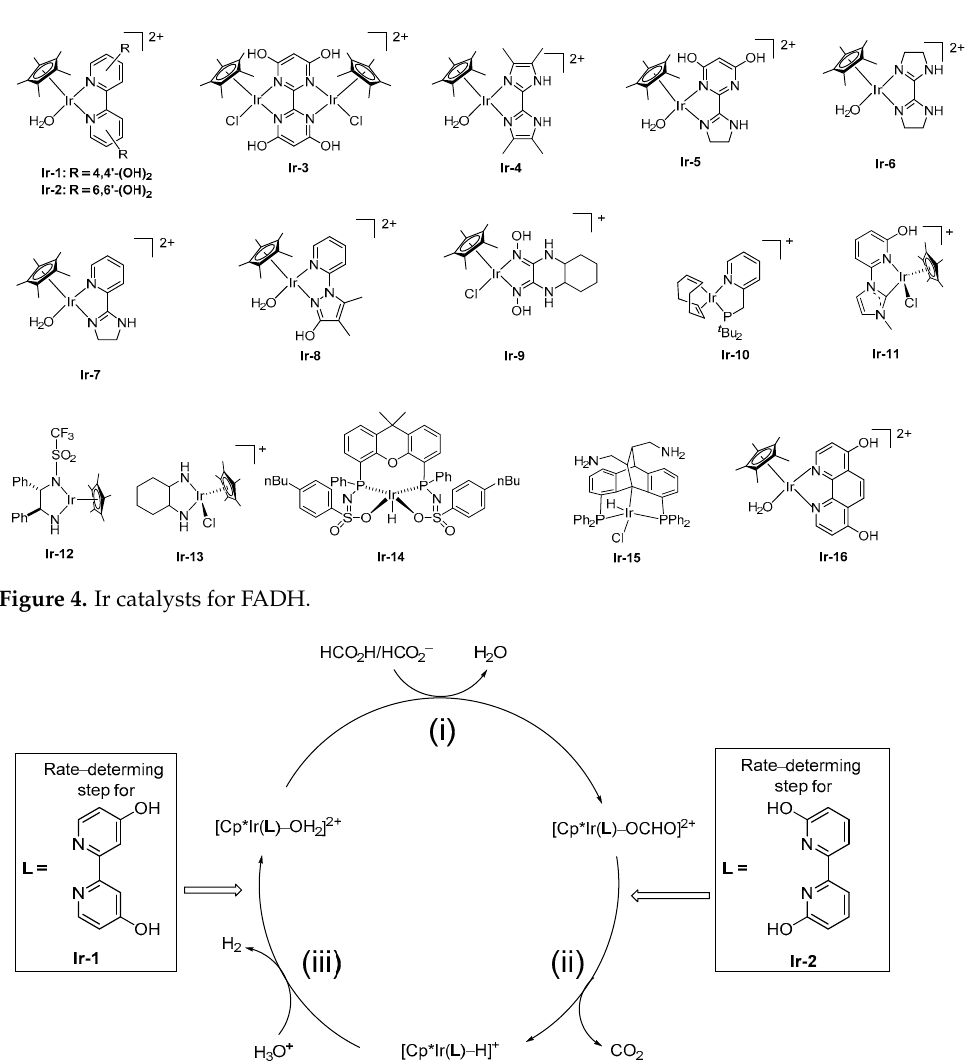
Figure 5. Proposed mechanism and different rate-determining steps of Ir-1 and Ir-2 [19].